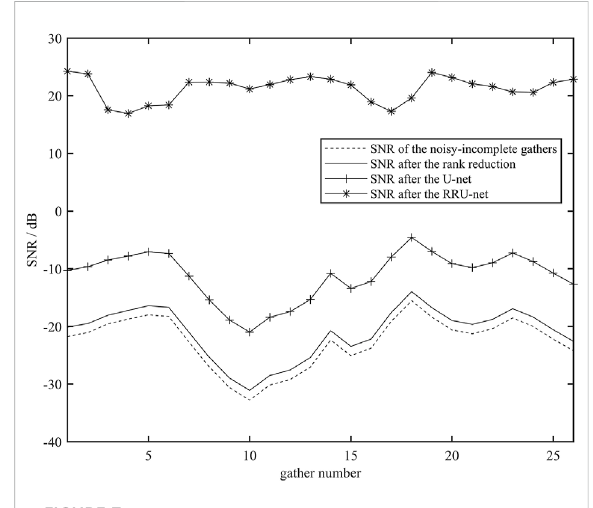
FIGURE 7 SNRs of the 26 shot gathers processed by three